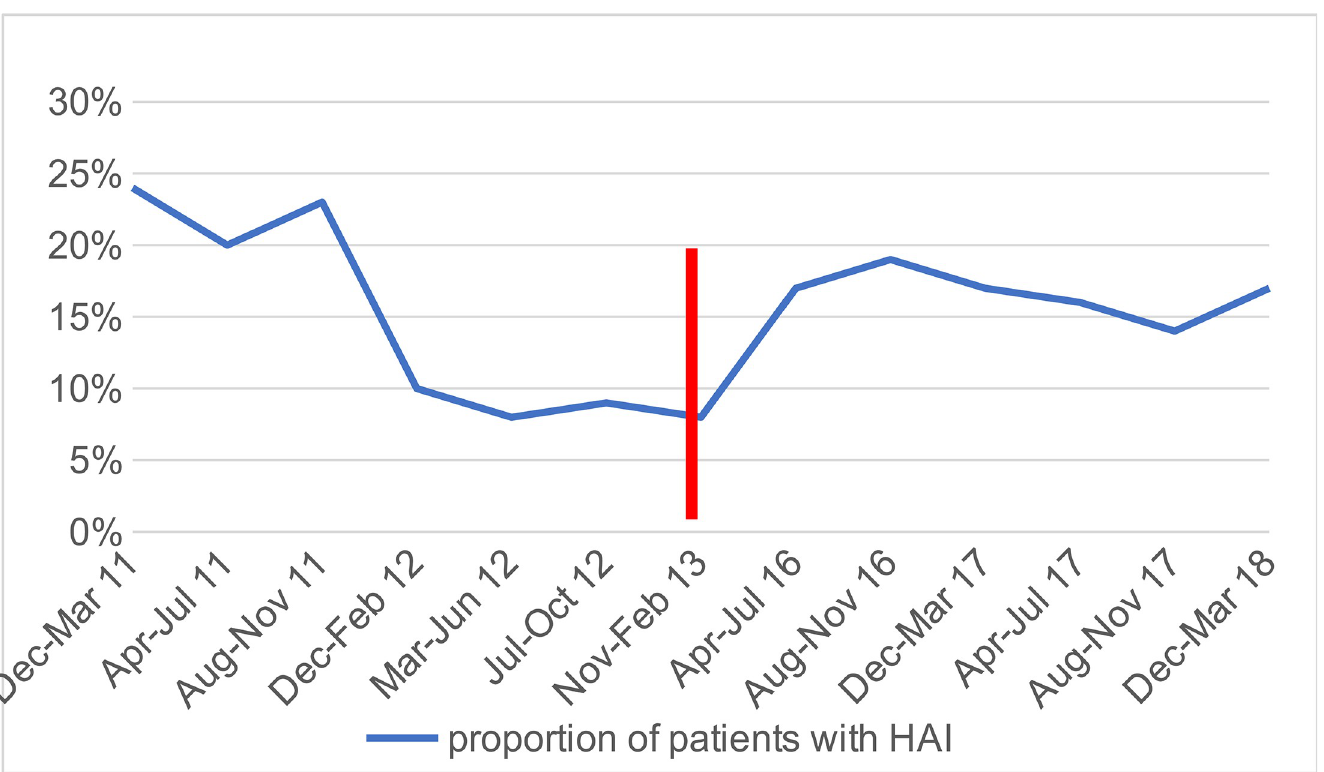
Fig 1. The proportion of healthcare-associated infections in the intervention and post-intervention era (December 2011 to February 2013) and the follow up evaluation era (started in February 2016), the gap between those periods is indicated with the red line.